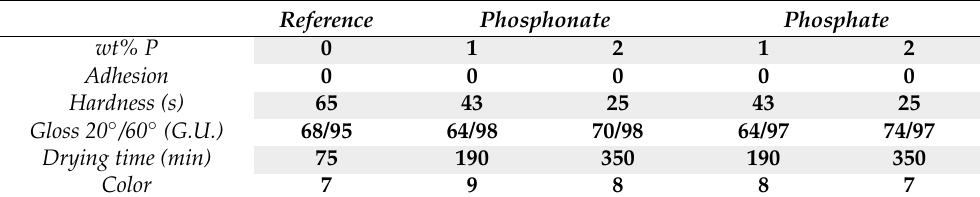
Table 6. Adhesion , hardness , gloss and drying time of reference EC alkyd resin and POxCR diluent EC alkyd resins. Reference Phosphonate Phosphate wt% P 0 Adhesion Hardness (s) 65 Gloss 20 ◦ /60 ◦ (G.U.)